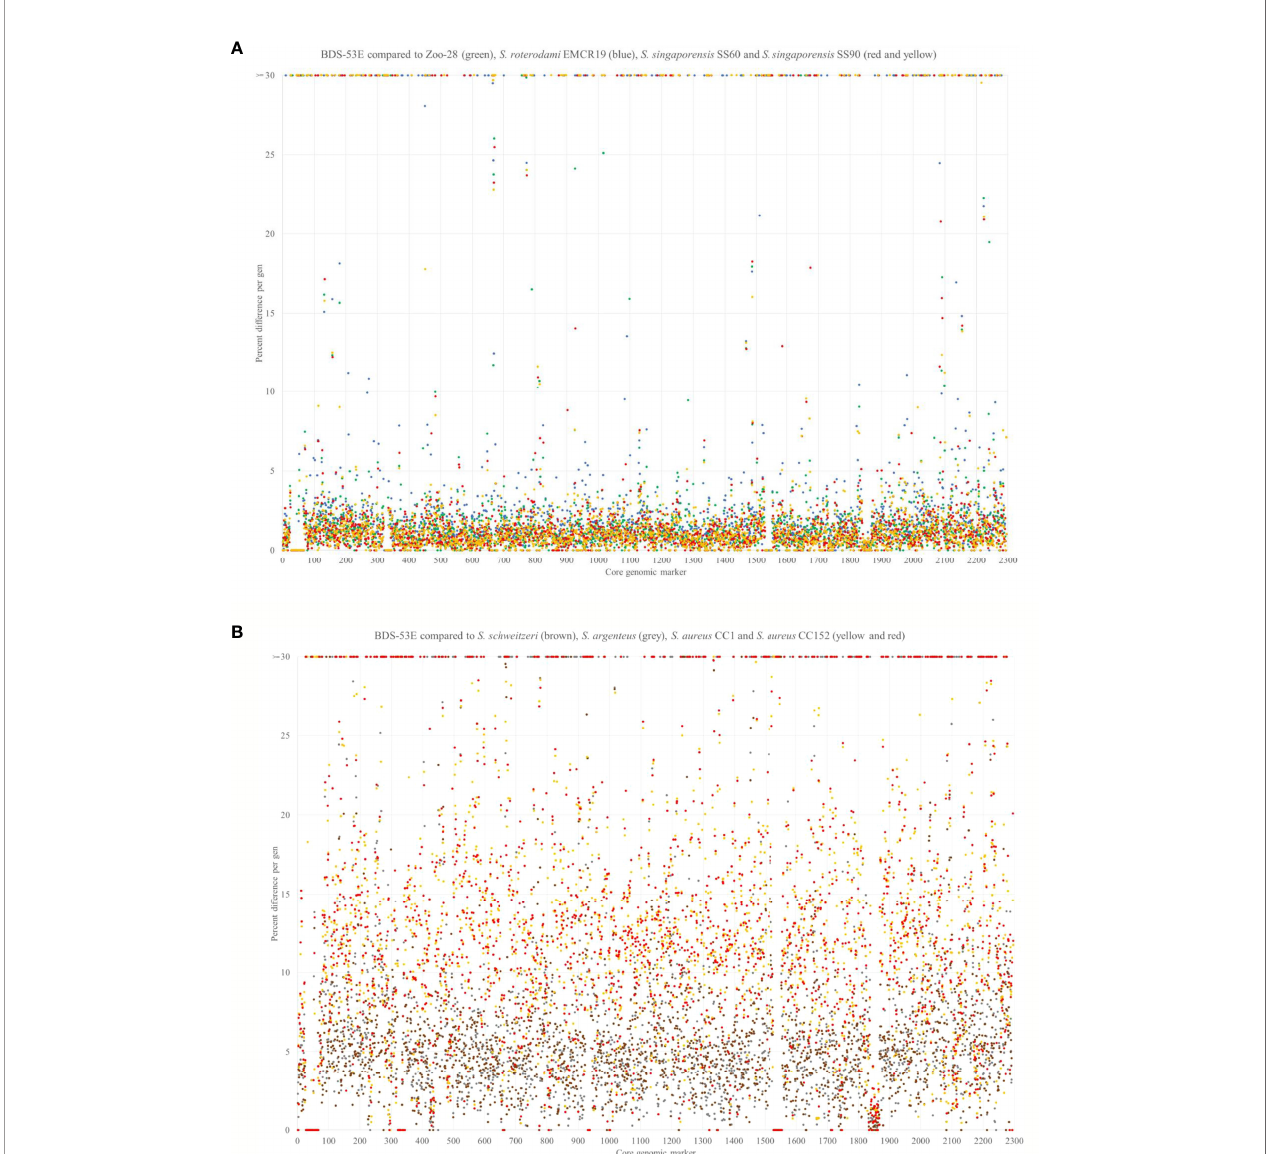
FIGURE 2 | (A) SNP analysis comparing 2292 non-motile genes of BDS-53E with the Zoo-28 (green), “ S. roterodami ” EMCR19 (blue) as well as with “ S. singaporensis ” SS60 and SS90 (red and yellow). For each single gene, the number of differences ( Supplemental File 7B ) to the comparator strains was counted and expressed in percentage. For genes that were present in one, but absent in the other isolate, this percentage was set as 100%. Note, for the genes that were found inverted in the Zoo-28 genome, reverse complement sequences were used for analysis. (B) SNP analysis comparing 2292 non-motile genes of BDS-53E with S. schweitzeri (NCTC13712, LR134304.1, brown), S. argenteus (MSHR1132, FR821777.2, grey), S. aureus CC1 (MW2, BA000033.2, yellow) and S. aureus CC152 (SA17_S6, CP010941.1, red). The genes around pos. 1550 represent a genomic island that is absent in the study isolates (protease genes splF, splE, splD2, splC, splB, splA , leukocidin lukD/E , lantibiotic epidermin gene cluster). The highly conserved genes around pos. 1850 are those encoding ribosomal